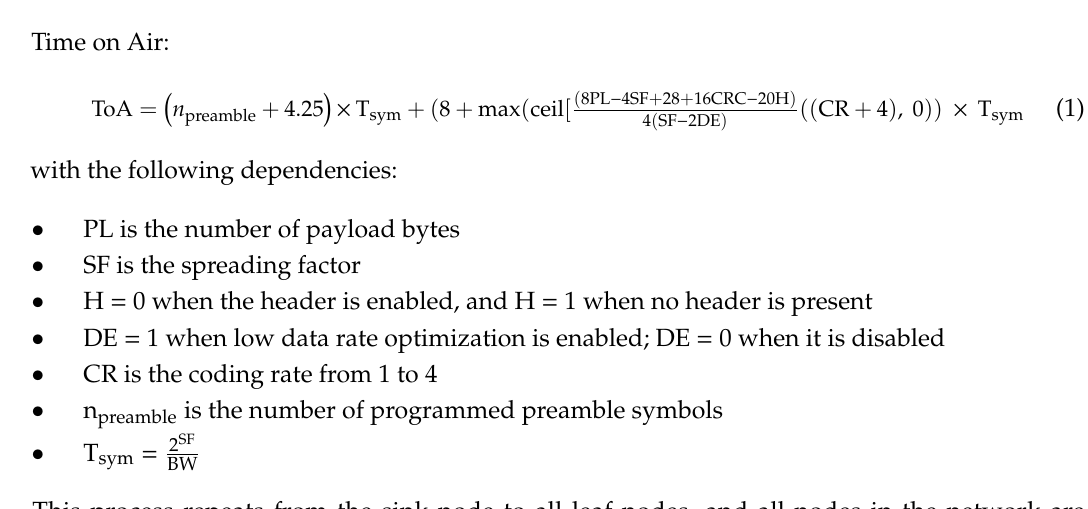
Figure 13. Resynchronizing time between the child and parent nodes.